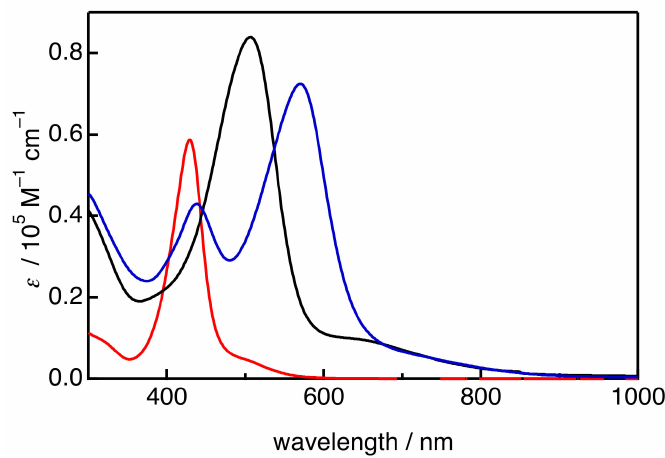
Figure 3. UV-vis absorption spectra of Me-Por (red), Me-Hex (black), and Me-Oct (blue) in CH 2 Cl 2